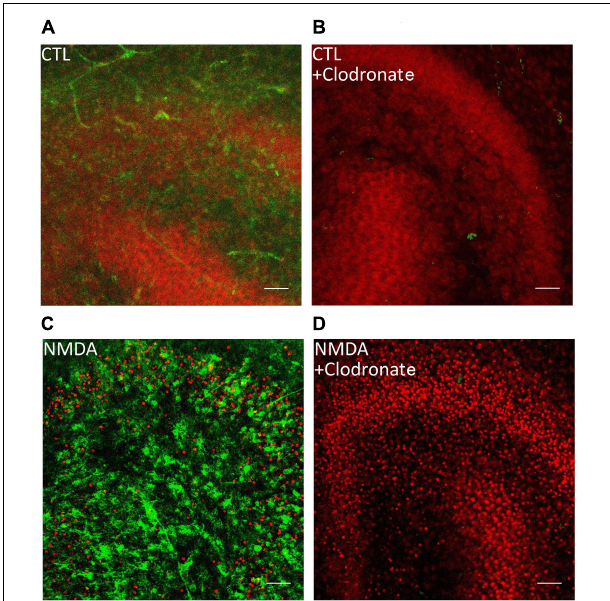
FIGURE 1 | Clodronate depletes microglial cells from OHSC. (A) PI labeled control OHSC with dentate gyrus and CA3. No PI positive nuclei (red) and ramified IB 4 (green) labeled microglial cells are visible. (B) Application of clodronate to CTL slices removed IB 4 positive microglial cells without damaging the neurons. (C) Treatment with NMDA led to massive increase in PI positive cells and IB 4 positive microglia. (D) Depletion of microglial cells led to exacerbation of neuronal damage after NMDA treatment in OHSC. Scale bar = 50 µ m.